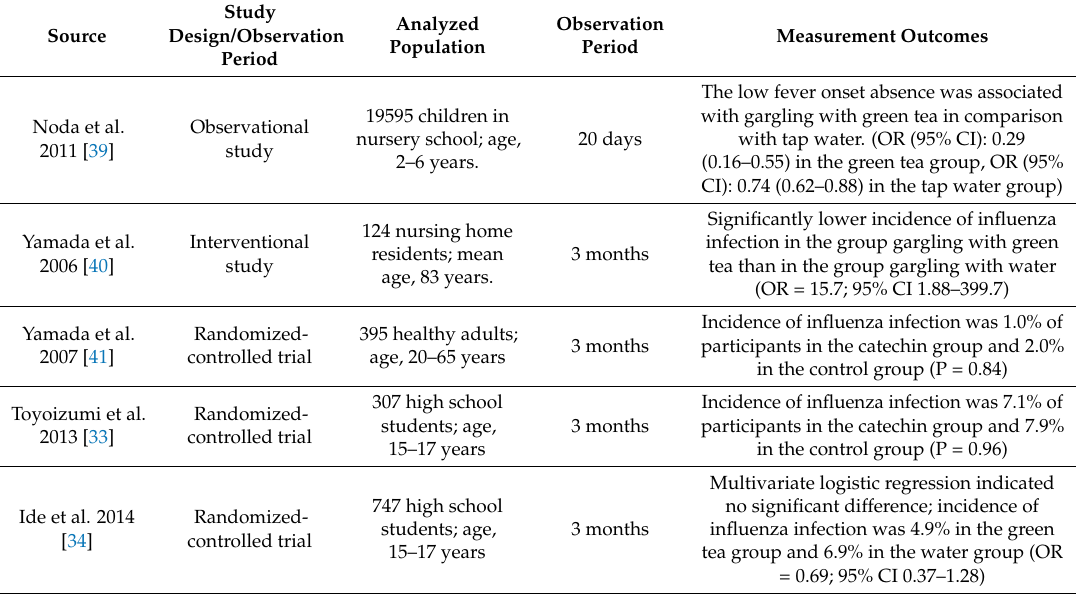
Table 2. Characteristics of major studies on gargling with tea and its ingredients for influenza